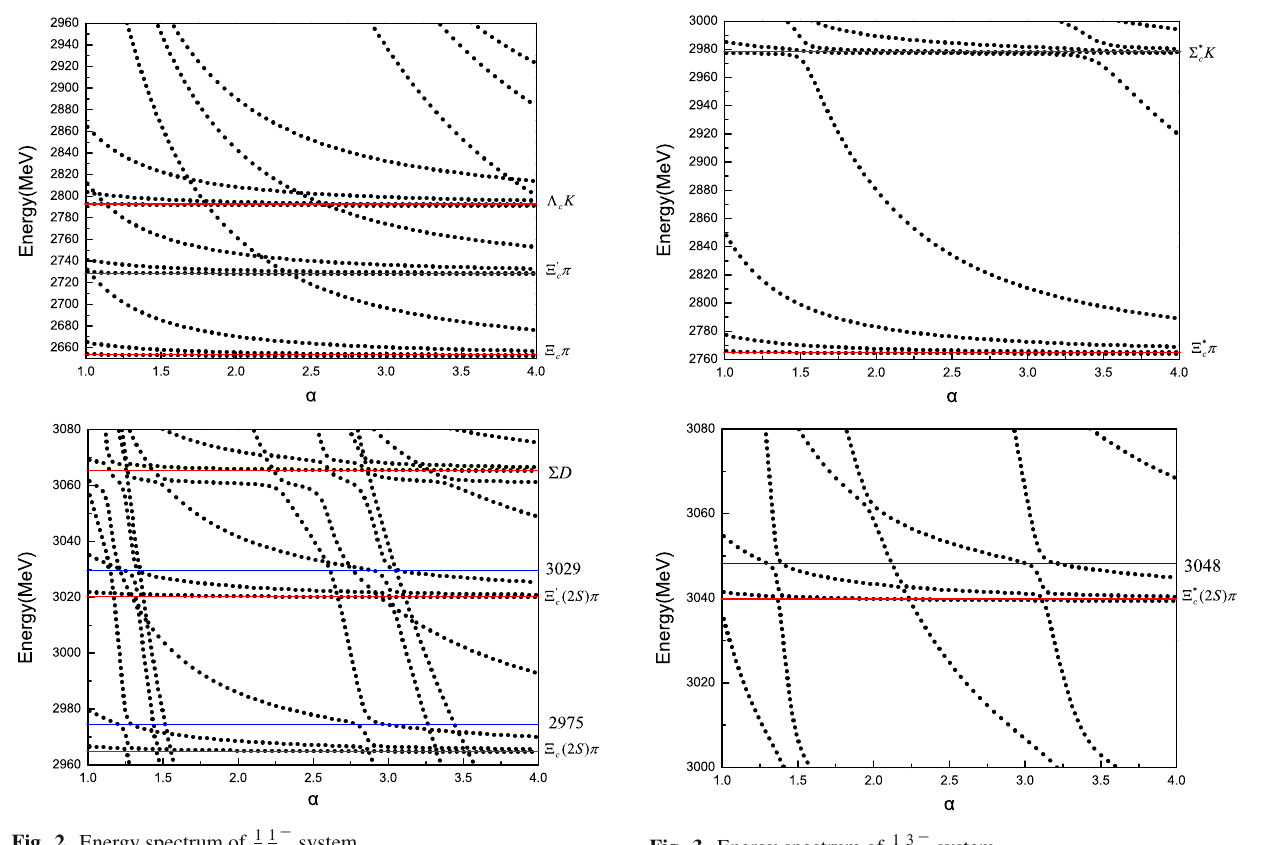
Fig. 2 Energy spectrum of 1